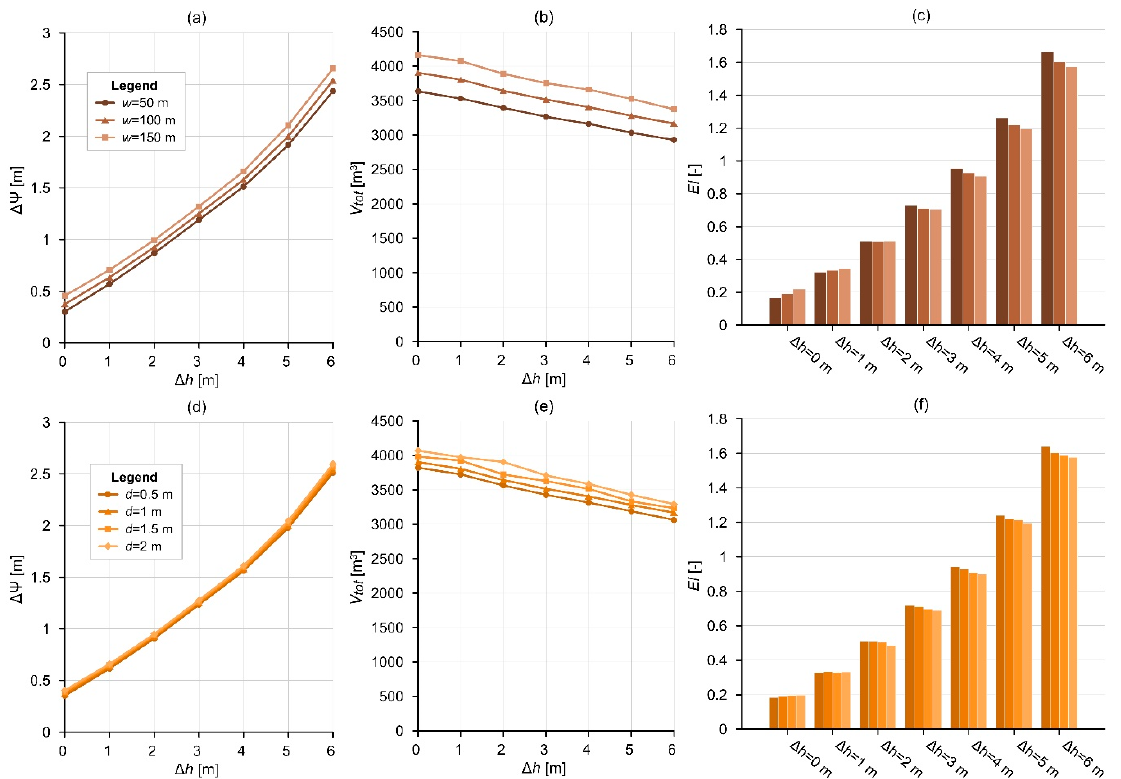
Figure 7. The effect of infiltration basin width ( w ) and water depth in the basin ( d ) on the water level increase ΔΨ —( a , d ), the cumulative water volume of infiltrating water V tot —( b , e ), and the Efficiency Index EI —( c , f ) after five years (( a – c ): SG ‐ 6/A, ( d – f ): SG ‐ 6/B) plotted against the hydraulic head difference ( Δ h ).